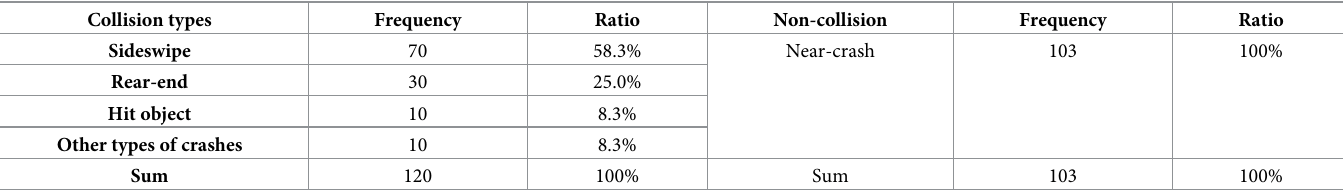
Table 2. Distribution of various types crashes on urban expressway.